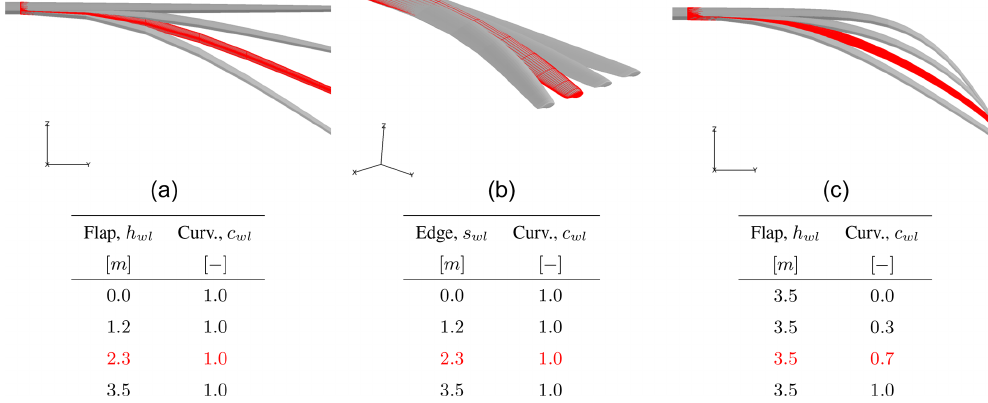
Figure 8. Tip design variables: flapwise tip displacement (a) , edgewise tip displacement (b) , and curvature of the tip (c) . The design variables used are listed below each visualization. The rows colored in red show the design variable settings used to generate the red meshes. The flapwise and edgewise displacement visualizations are made with no curvature, forcing the tip to be as straight as possible. The curvature visualization is made with a maximally flapped tip. Grid level 3 is used to visualize mesh